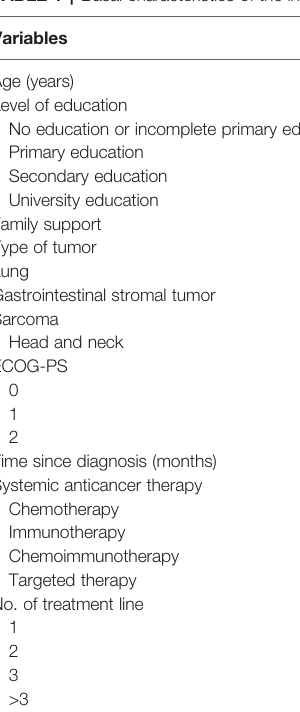
TABLE 1 | Basal characteristics of the included patients.